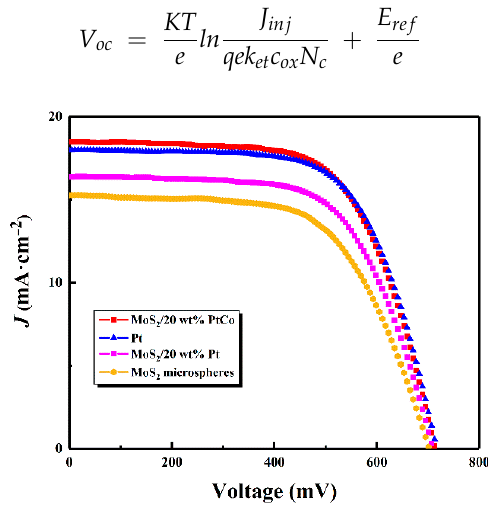
Figure 8. J–V curves of dye-sensitized solar cells (DSSCs) with different counter electrodes. Table 1. Detailed photovoltaic parameters and EIS parameters of DSSCs based on different counter electrodes.